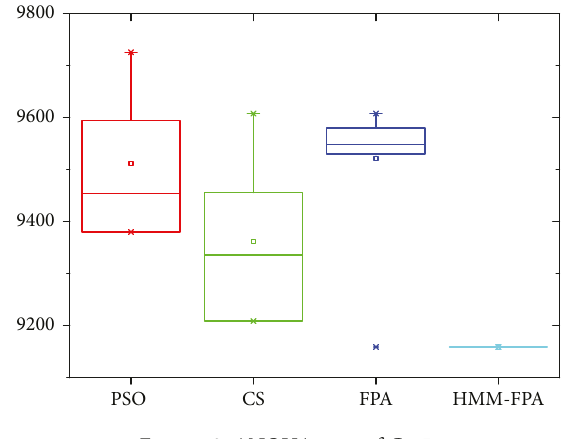
Figure 8: ANOVA tests of Car5.